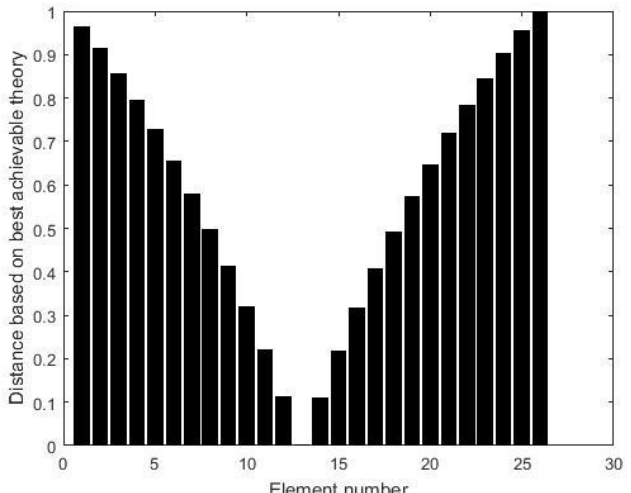
' Figure 2. The distance δ (cid:48) ( i = 1 ∼ 26) for each element when element 13 is damaged (no  ( 26 ~ 1 = i ) for each element when element 13 is damaged (no noise). Figure 2. The distance i i